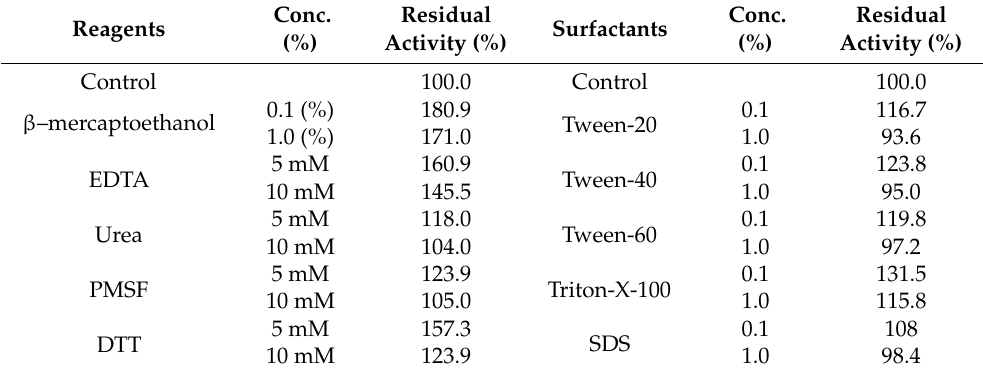
Table 5. Effect of different inhibitors on enzyme stability.